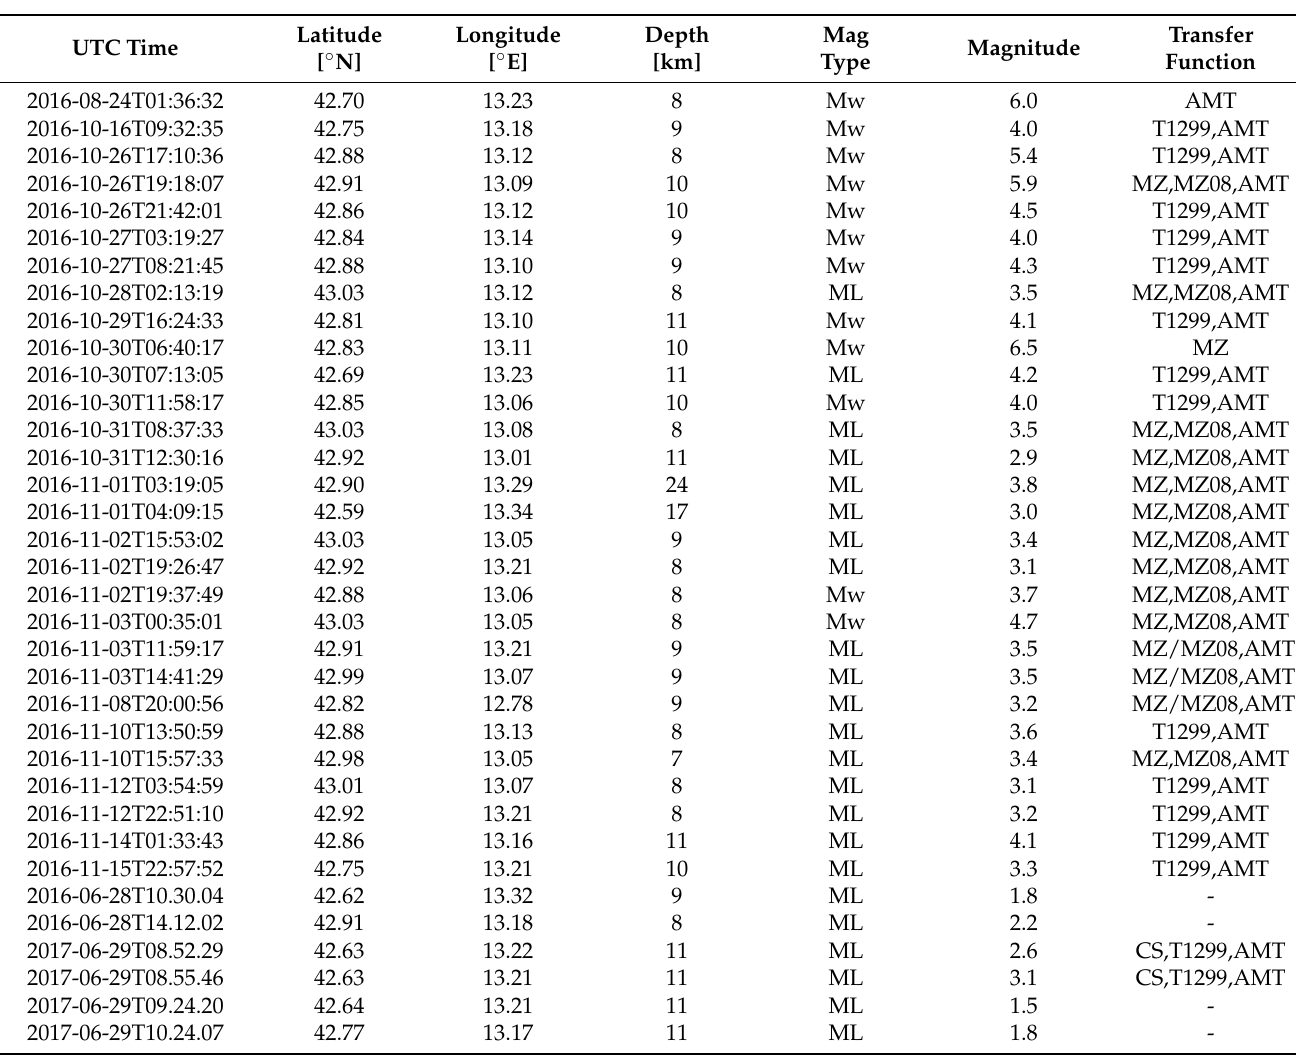
Table 1. Location and magnitude of earthquakes whose recordings were used in this study (available at http://cnt.rm. ingv.it/, accessed on 23 April 2021). Last column lists the stations that recorded the event used for the transfer function computation